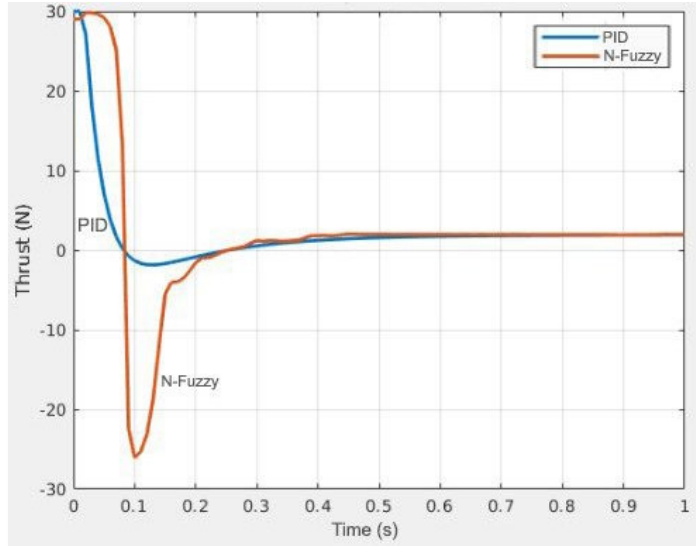
Figure 21. The results compare the Z position (attitude) of the Neural-Fuzzy controller and the classic PID controller (wind action).